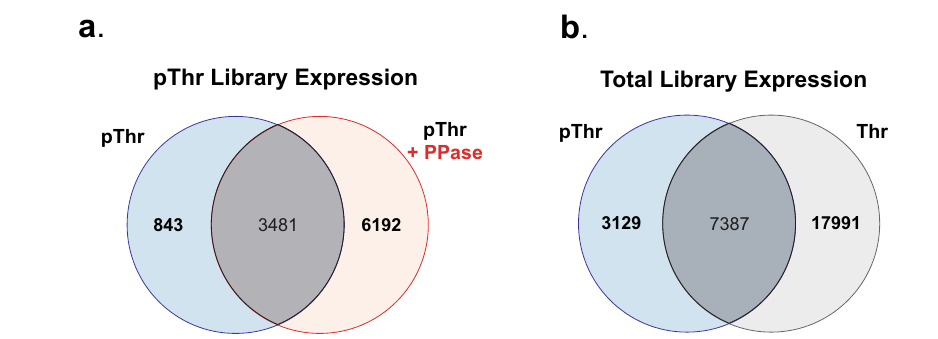
Fig. 2 | Development and expression of a human pThr phosphosite library. a Venn diagram comparing pThr phosphosites identi fi ed with and without phos- phatase treatment. Data were combined from two biological replicates, each divi- ded between phosphatase treatment groups. b Combined coverage of